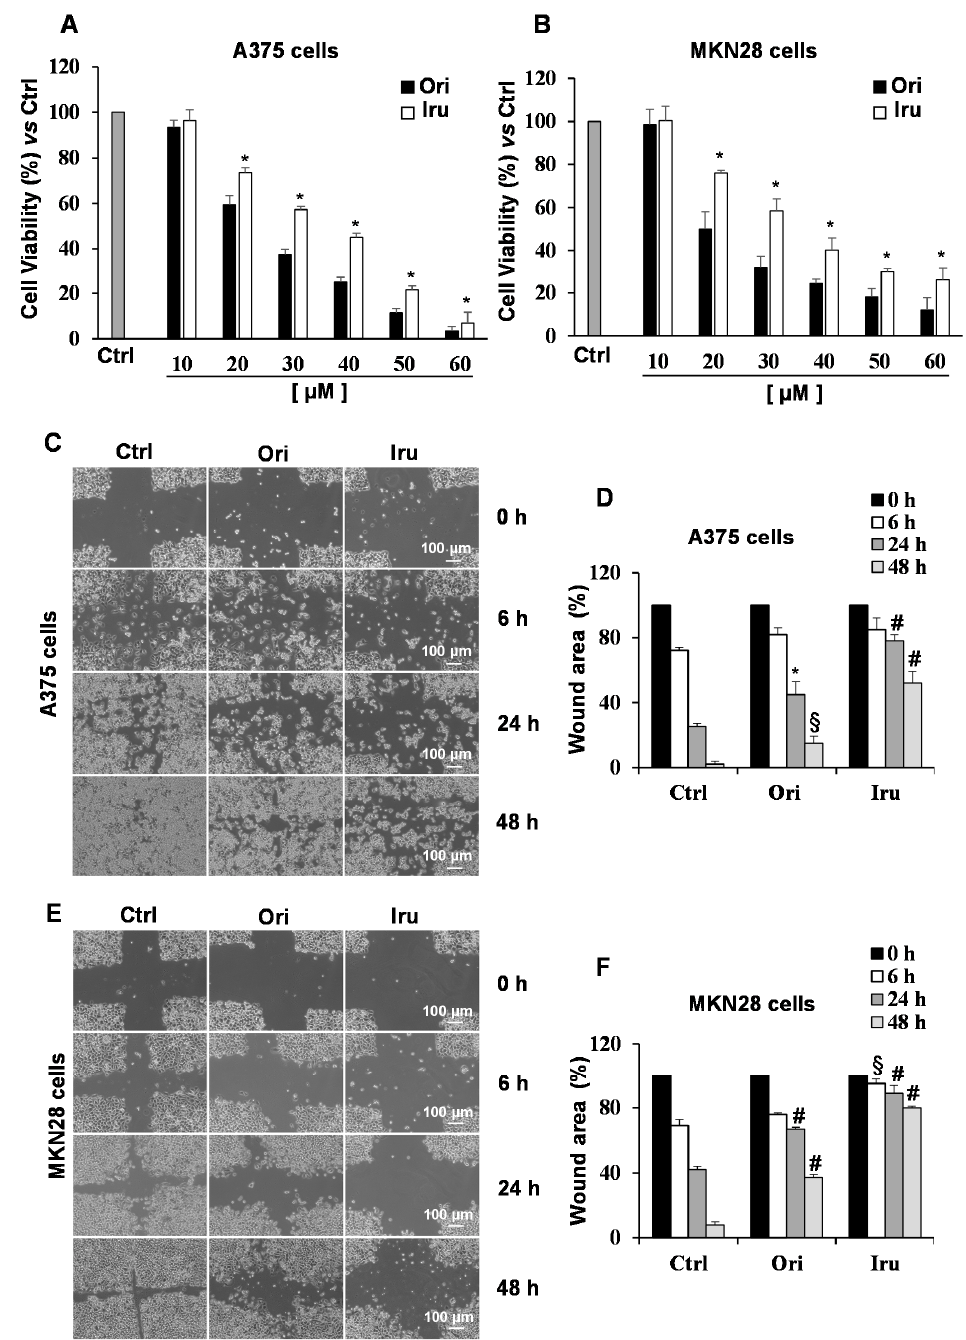
Figure 3. Effect of Ori and Iru exposure on A375 and MKN-28 cell proliferation and cell migration. ( A ) A375 and ( B ) MKN28 cell proliferation was quantitated by the cell viability reagent (PrestoBlue, PB) at 24 h. Results are presented as percentage (mean ± SD) ( n = 6) of the control cells, cultured in DMEM with 0.1% DMSO, set as 100%. (*) indicates histograms statistically different from Ori treated cells (* p < 0.05). ( C , E ) Representative phase-contrast-microscope (10× objective) images of the wound healing assay on A375 and MKN28 cells. ( D , F ) Quantification of wound area was performed using the free image-processing software ImageJ, version 1.47. For each treatment, data show the wound area at the indicated time in comparison to that of the open wound at time 0, set as 100%. Results are presented as mean ± SD ( n = 9). Columns with (*, §, #) were statistically di ff erent from untreated control cells (* p < 0.05, § p < 0.01, # p <